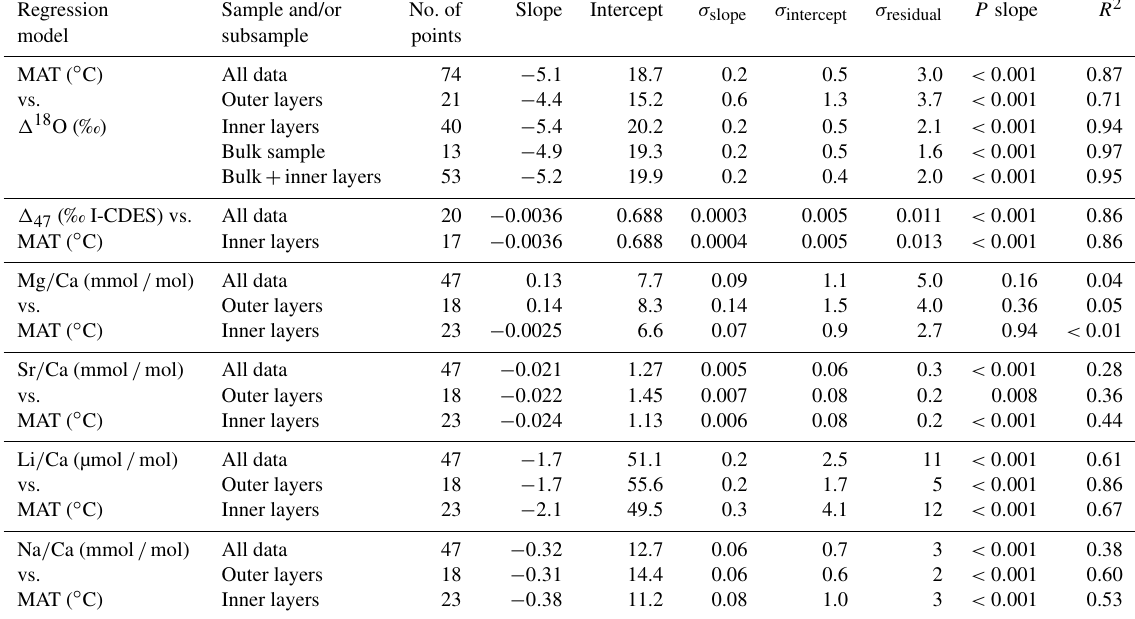
Table 3. Linear regression model parameters for the geochemical parameter–temperature relationship tested and displayed in Fig. 1.